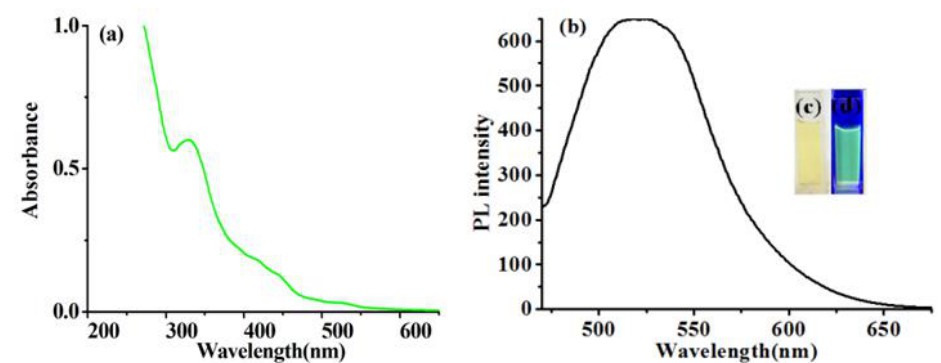
Figure 1. ( a ) UV-Vis spectrum of green-emissioned carbon dots (G-CDs) solution; ( b ) fluorescence spectrum of G-CDs solution; ( c ) daylight; ( d ) 440 nm blue light.